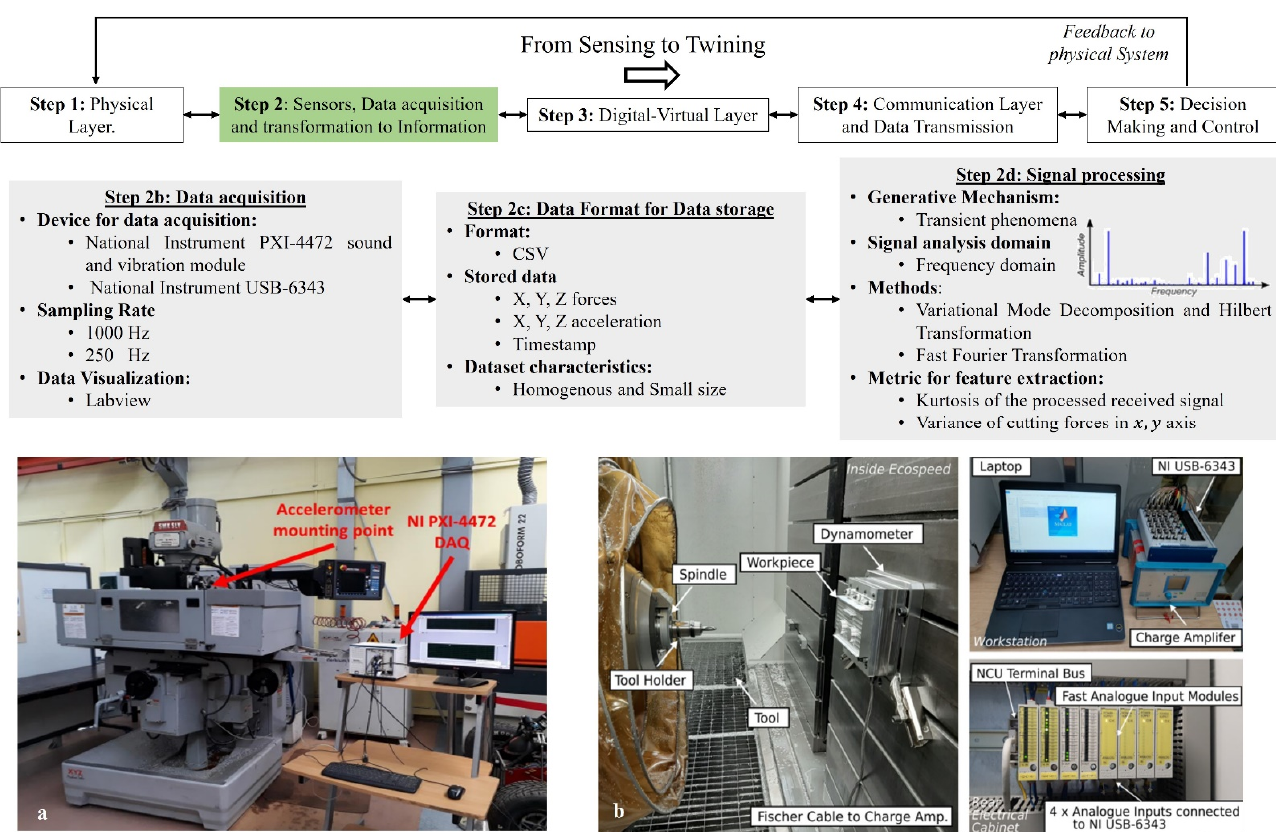
Figure 11. From sensor selection to data acquisition and signal processing ( a ) [73], ( b )